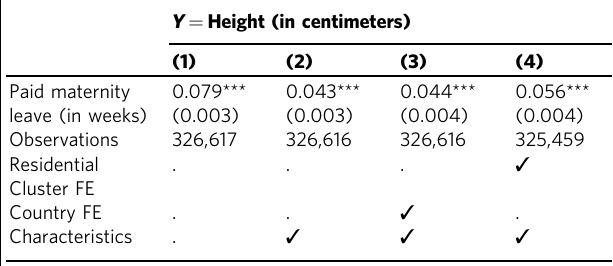
Table 3 The impacts of paid maternity leave on